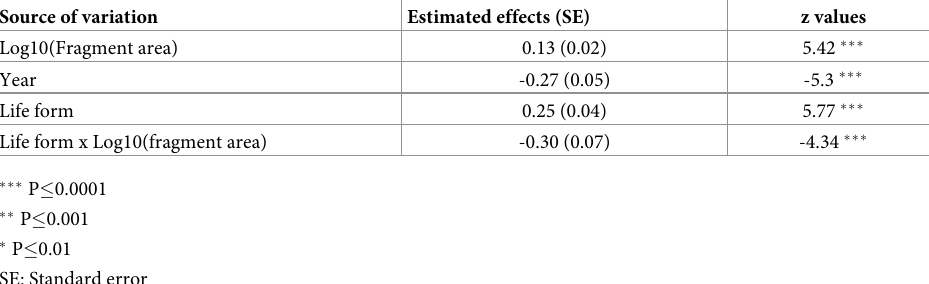
Table 2. Results of generalized linear mixed effects models on species richness. Effects of fragment area, year (2003–2013), and life form (woody and non-woody) on plant species richness in 18 Chaco Serrano forest fragments. We report the effects and z values estimated from the reduced